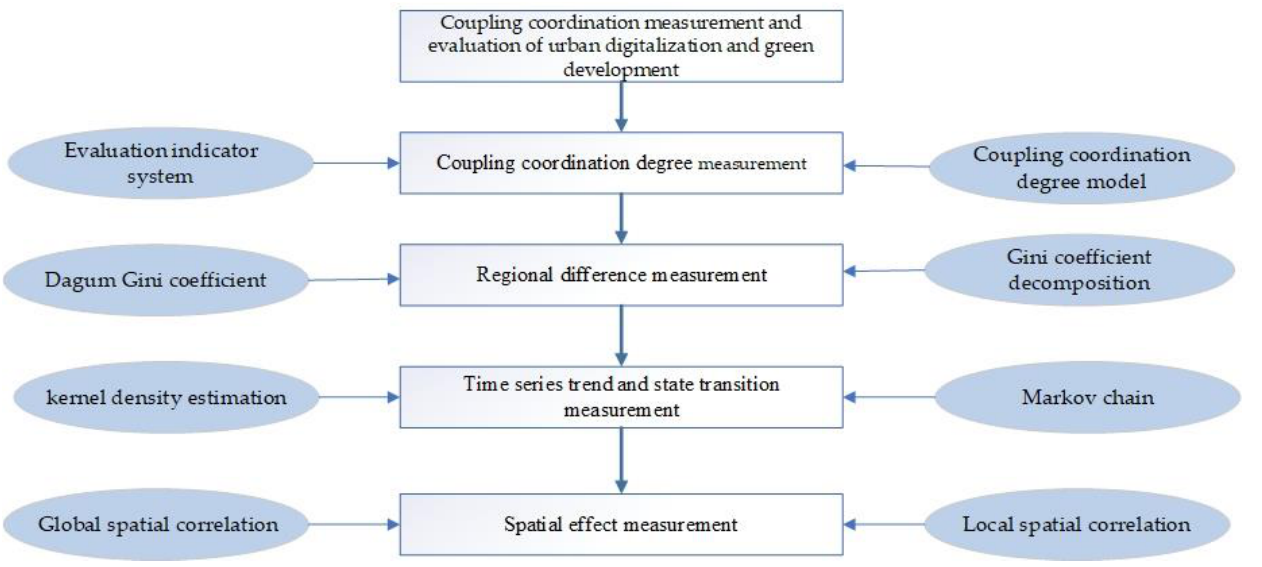
Figure 2. The research framework and the research methods.